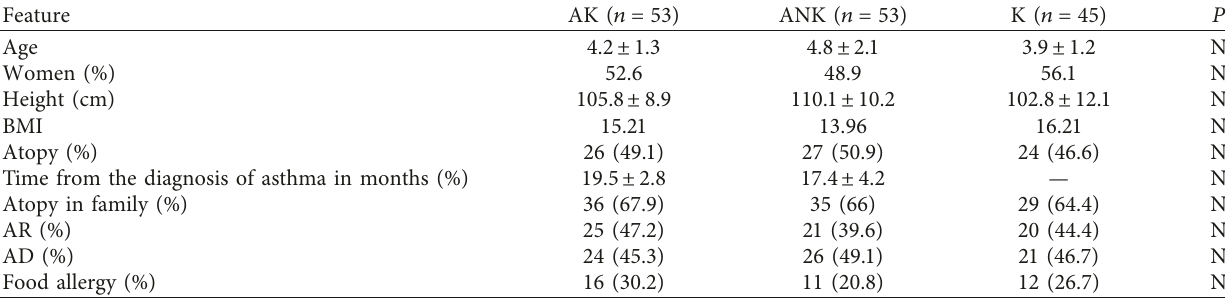
Table 1: Characteristics of the studied groups.